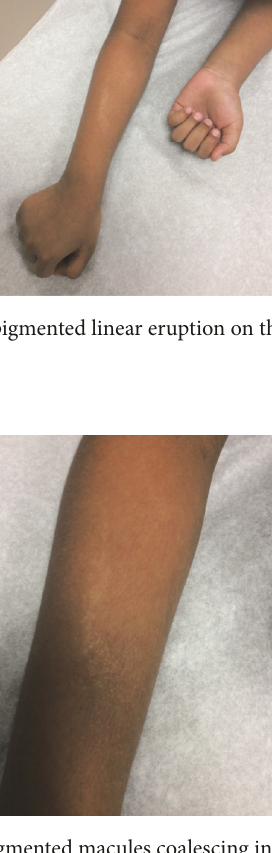
Figure 4: Extension of eruption along the left posterior thigh.